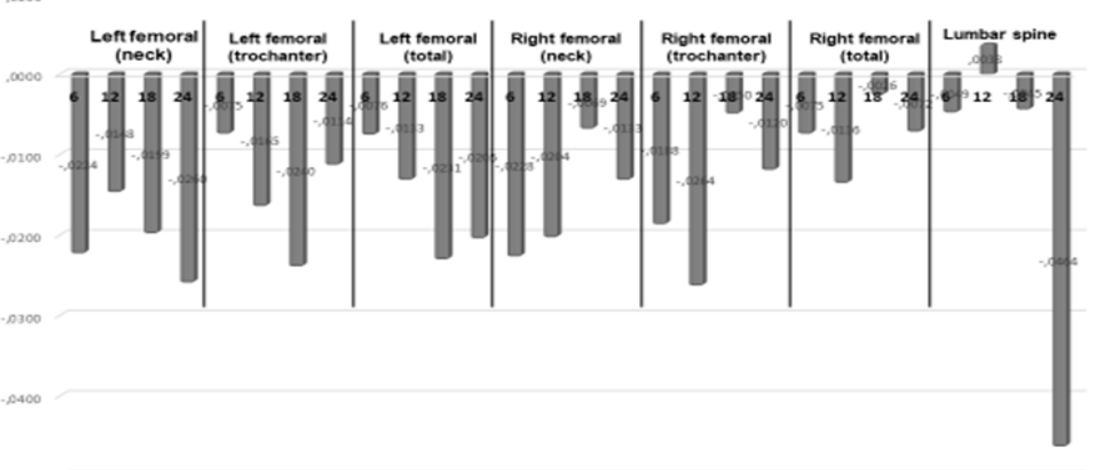
Figure 2. A transient non-significant decrease of BMD was observed at all sites 6 months after GC administration, which subsequently appeared to be restored while in the lumbar spine this trend for reduction continued up to 24 months.